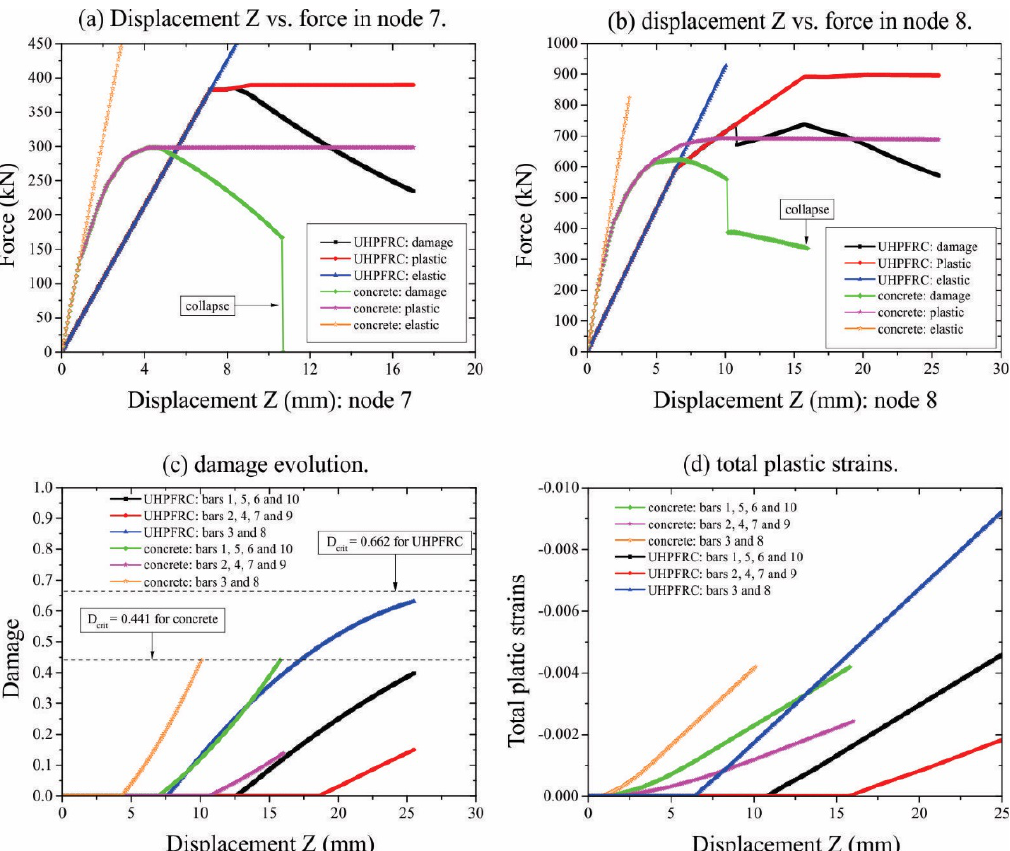
Figure 5. (a) Displacement Z vs. force in node 7; (b) displacement Z vs. force in node 8; (c) damage evolution in the bars and (d) total plastic strains in the